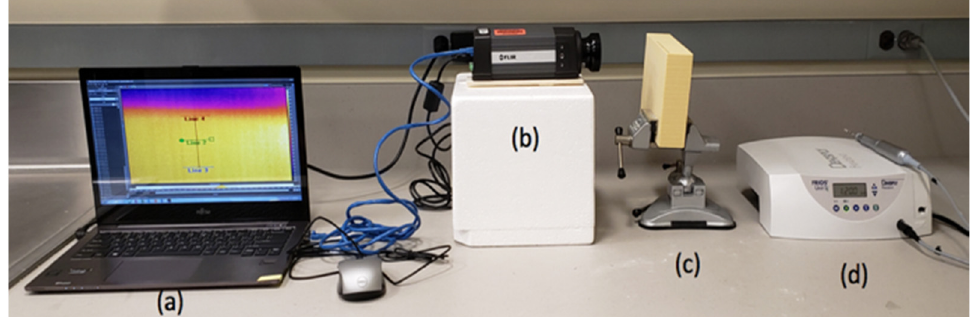
Figure 1. ( a ) Laptop with thermography camera software, ( b ) thermographic camera, ( c ) polyurethane bone block mounted in a vise, and ( d ) implant motor and contra angle .